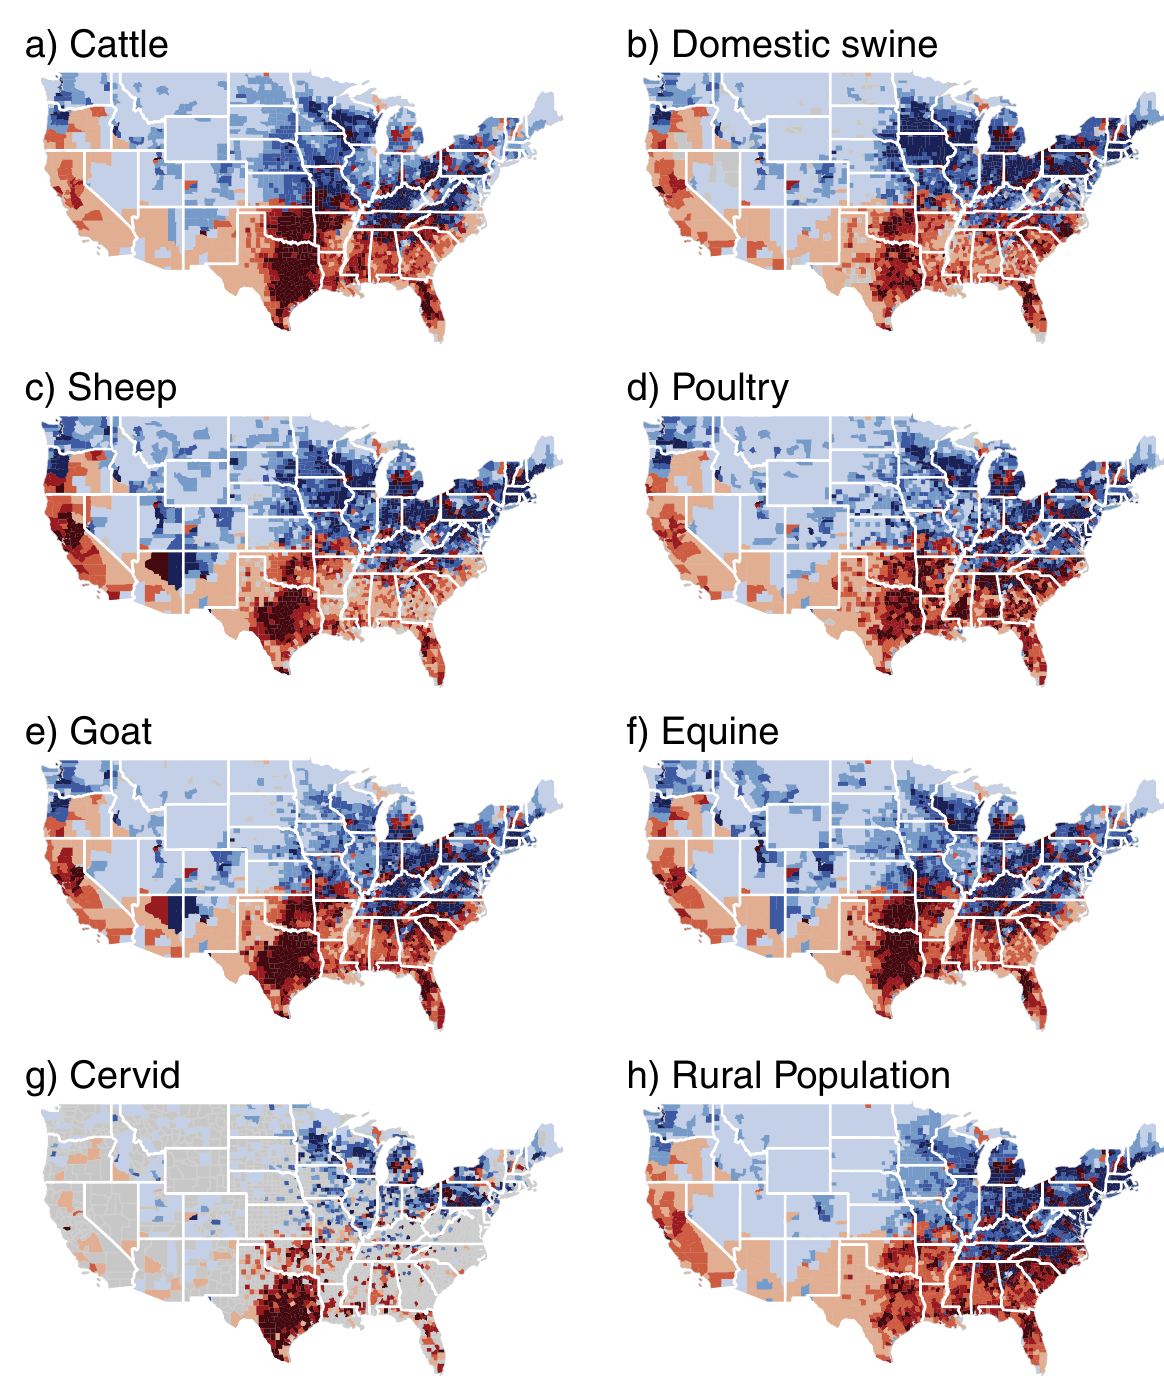
Figure 4. County level co-occurrence of wild pigs, agricultural commodities, and rural human populations in the contiguous United States for 2012. Red shading denotes by quartile the absolute farms density (farms per km 2 ) or rural human population density (people per km 2 ) within counties co-occurring with wild pigs while blue shading indicates counties without wild pigs. Maps were generated by combining publically available data (see methods) describing wild pig distribution from Southeast Cooperative Wildlife Disease Study (SCWDS), agriculture data from National Agricultural Statistics Service (NASS) Quick Stats database, and rural human population data available from the United States Census Bureau. Maps were created using the maptools package version 0.9.2 101 in R version 3.3.0 102